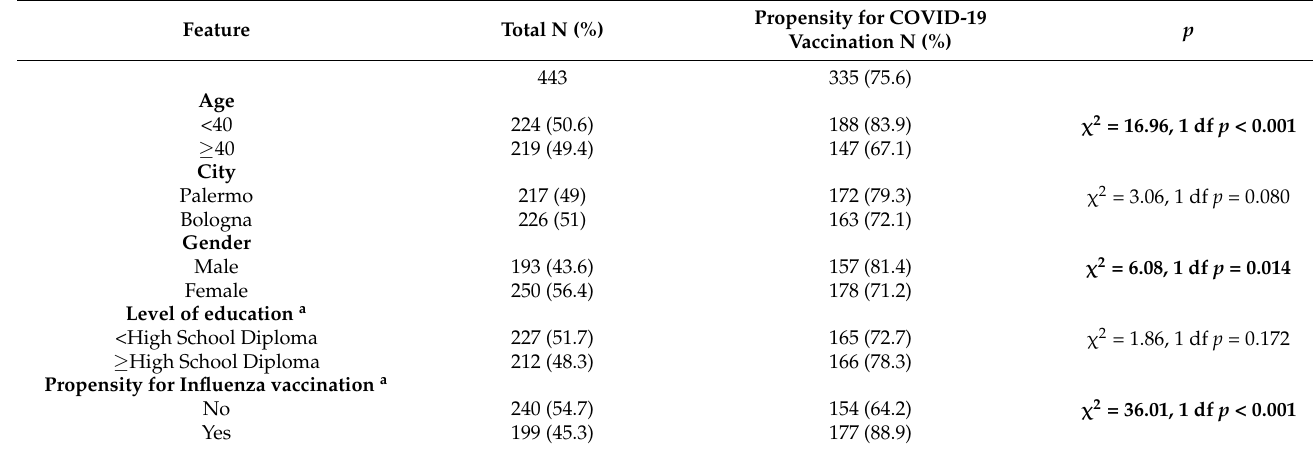
Table 1. Main features of the sample and propensity for COVID-19 vaccination according to several socio-demographic determinants.